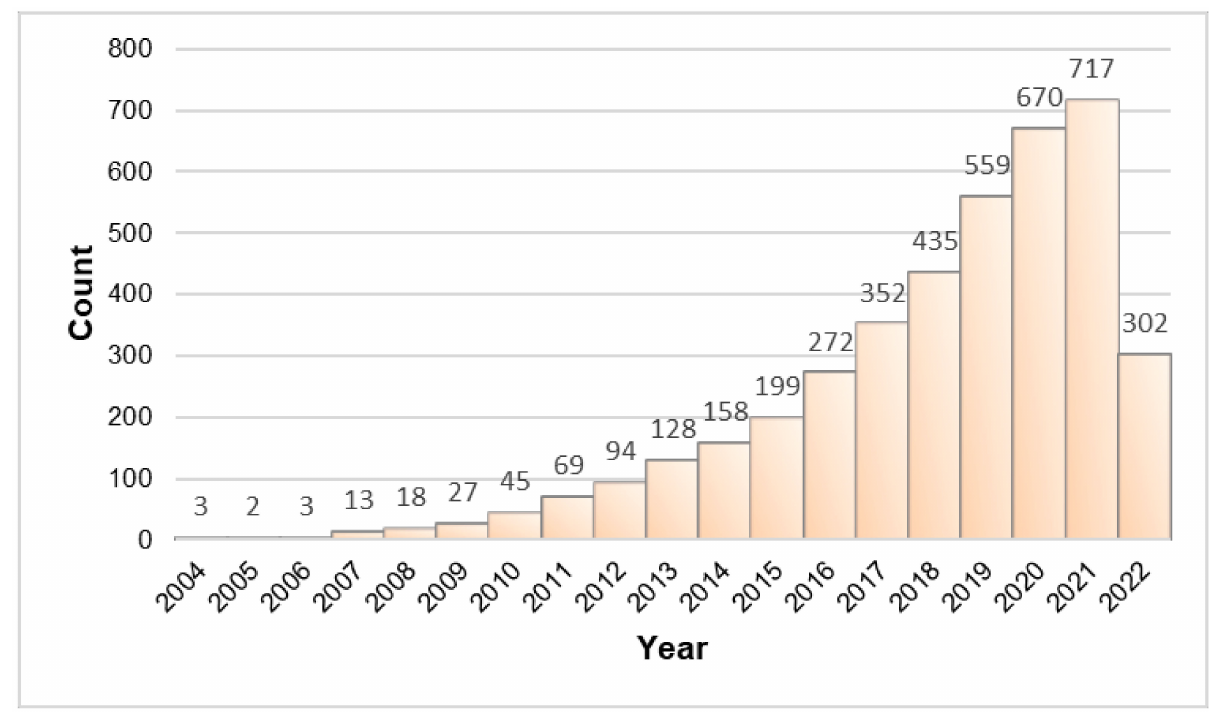
Figure 2. The increasing trend of research into nanomaterials and antibacterial resistance, as reflected by increasing publications in PubMed (updated: 7 June